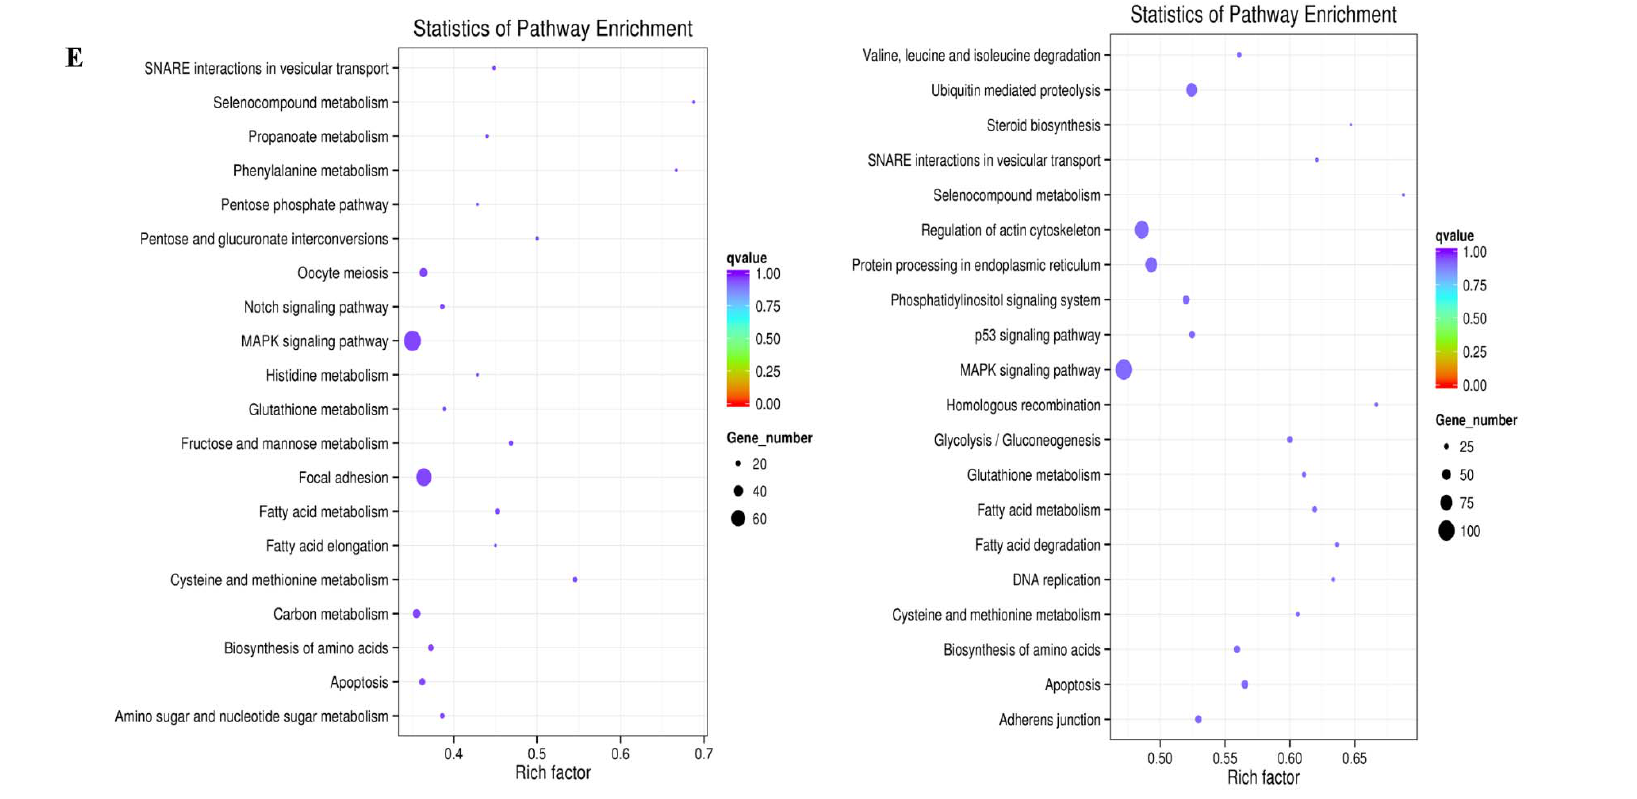
Figure 2. Common up- and downregulated miRNAs and their target genes in response to Newcastle disease virus (NDV) infection. ( A ) Venn diagram showing the number of common differentially expressed miRNAs in F48E9 and La Sota infections. Purple and yellow represent the differentially expressed miRNAs after infection with F48E9 and La Sota, respectively, and the common parts represent the same differentially expressed miRNAs when infected with F48E9 and La Sota. The numbers in each section indicate the numbers of differentially expressed miRNAs. ( B ) Heatmap of 35 common differentially expressed miRNAs in both F48E9 and La Sota infections. ( C ) Statistical table showing the number of common up- and downregulated miRNAs and the numbers of their predicted target mRNAs. ( D ) GO analysis of the predicted target genes with common up- and downregulated miRNAs in NDV infection. The top panel shows the GO enrichment analysis of each of the top 20 significant differences in the upregulated miRNAs, and the lower panel shows the GO enrichment analysis of each of the top 20 significant differences in the downregulated miRNAs. ( E ) KEGG analysis of the predicted target genes with common up- and downregulated miRNAs in NDV infection. The left panel shows the KEGG enrichment analysis of each of the top 20 significant differences in the upregulated miRNAs, and the right panel shows the KEGG enrichment analysis of each of the top 20 significant differences in the downregulated miRNAs.